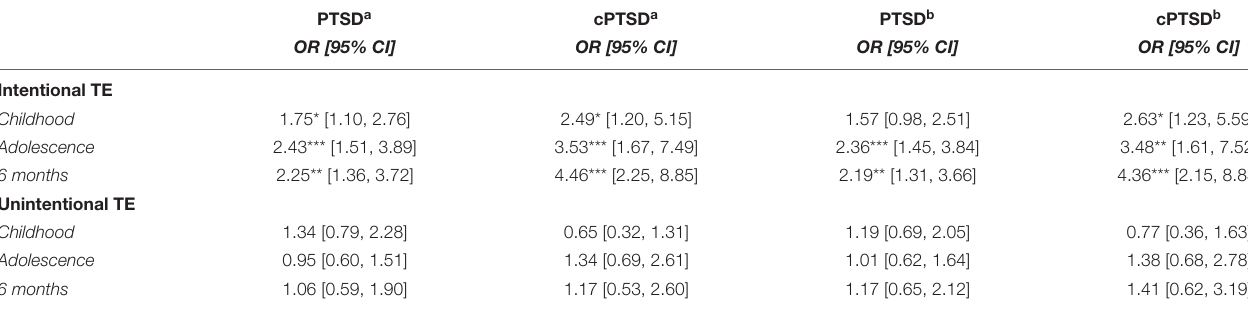
TABLE 3 | Association between PTSD, cPTSD and traumatic experiences (multinomial logistic